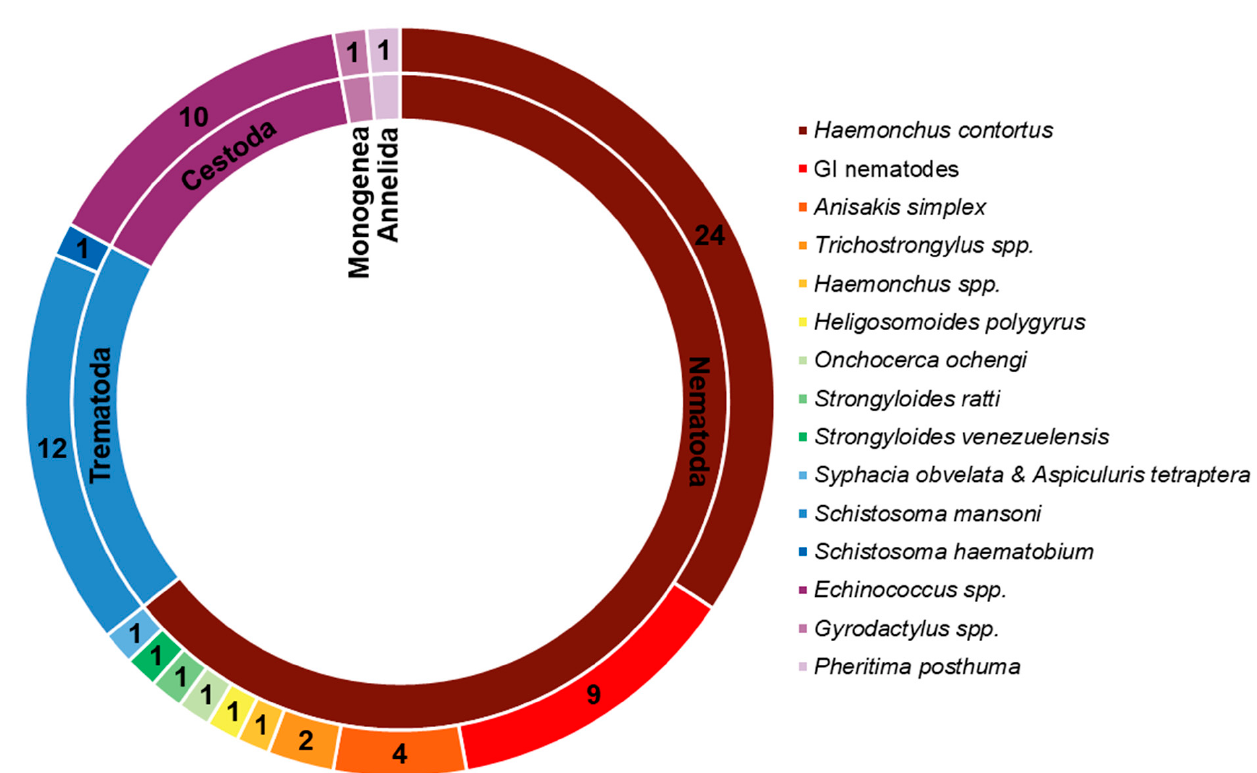
Figure 3. Distribution of species and their taxonomy in the retrieved publications. Cestoda, Trematoda and Monogenea belong to the phylum Platyhelminthes.